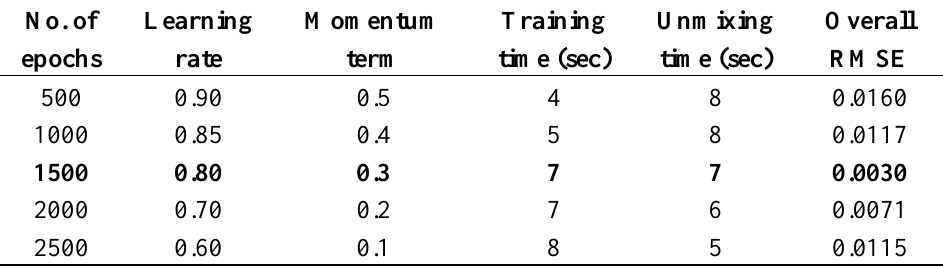
Table 1. Details of training for unmixing of simulated dataset.